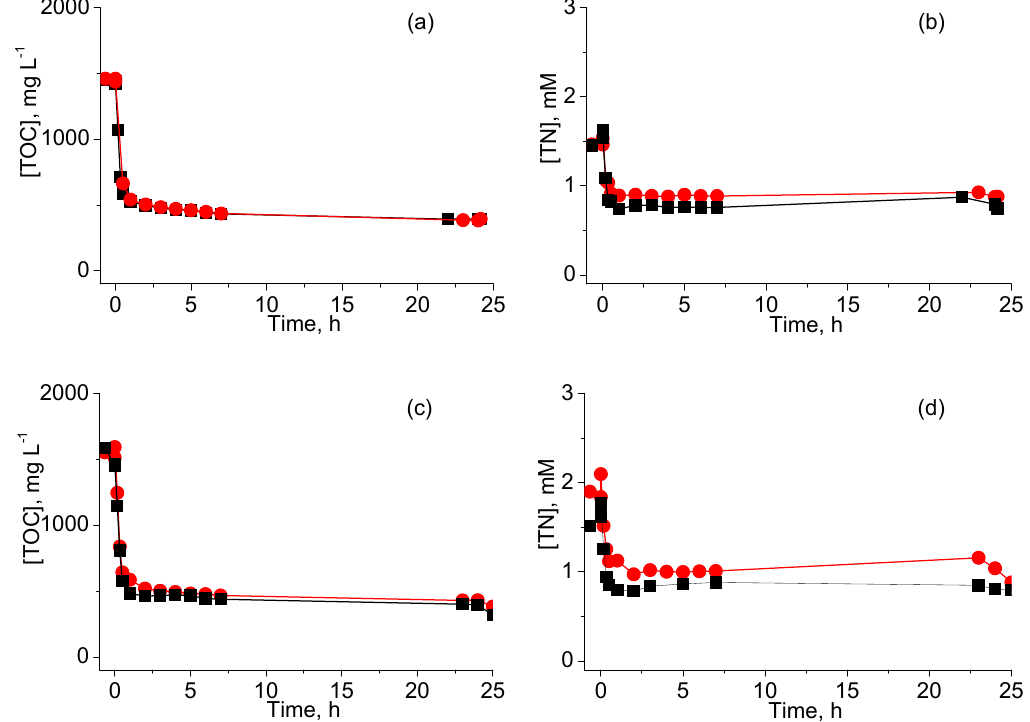
Figure 6. Evolution of TOC and TN in the presence of ( a,b ) Pt/TiO 2 or ( c,d ) Pt/ZrO 2 . Fresh catalysts ( ■ ), used catalysts ( • ).